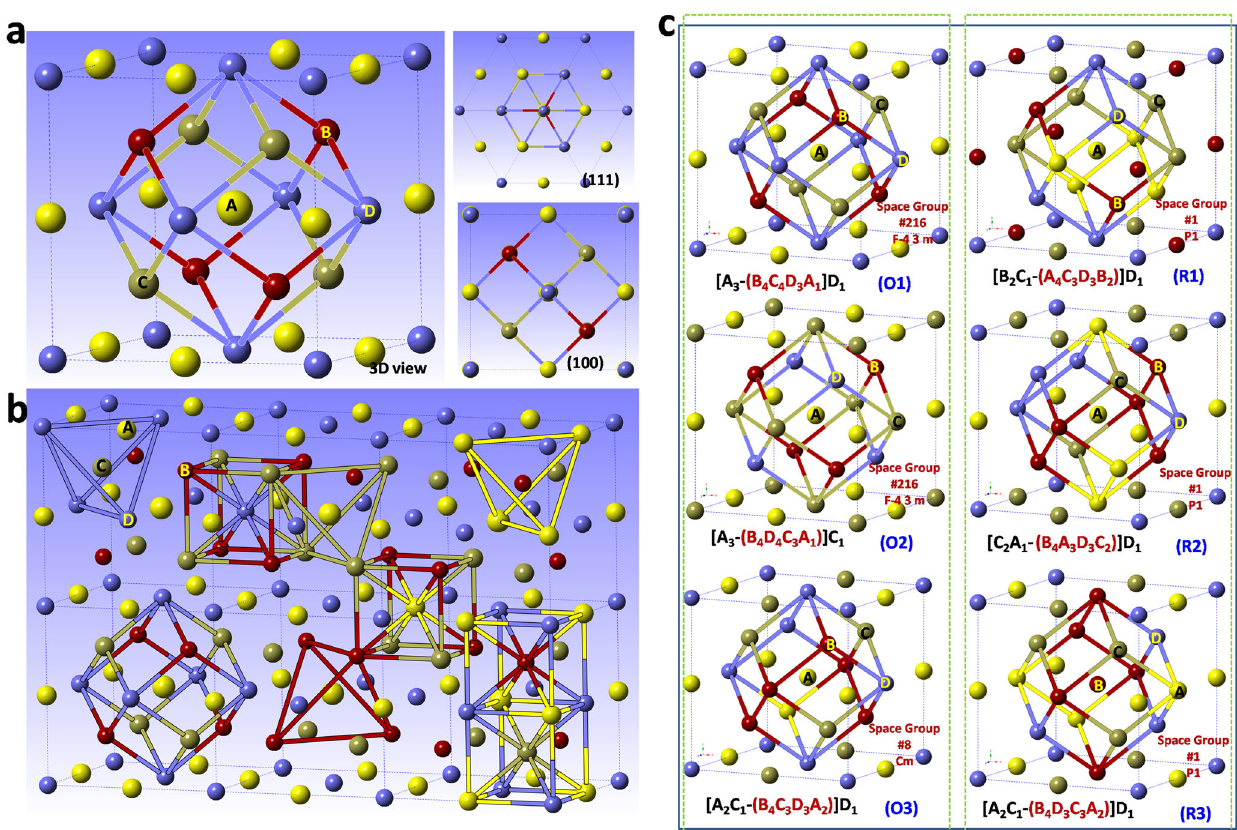
Fig. 1 Schematic structure of the cluster+glue-atom model in a body-center-cubic ( BCC ) lattice of an ABCD quaternary alloys. a 3D, (111) supercell and (100) supercell views of the CN14 cluster (the coordination number is 14) with its glue atoms (golden atoms at edge centers and blue atoms in the vertex positions). b Topological structure of each type of element in the BCC lattice generated by the CN14 cluster+glue- atom model. c Con fi gurational transitions of the CN14 clusters via atomic rearrangements, including three ordered con fi gurations (O1 and O2 with the #216 space group, and O3 with the #8 space group) and three random arrangements (R1, R2, and R3 with the #1 space group). The various colors characterize the different kinds of alloying elements for the given equiatomic ABCD BCC HEA alloys, which are kept consistently in the following related fi gures. In particular, the A, B, C, and D elements are in yellow , wine , green , and blue ,